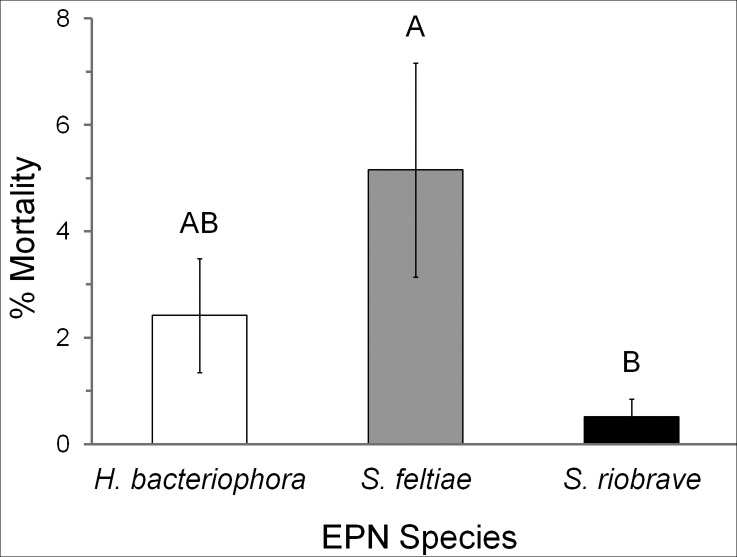
Mortality of wheat stem sawfly (Cephus cinctus) from field wheat stubble treated with three species of EPNs (Heterorhabditis bacteriophora, Steinernema feltiae, and Steinernema riobrave).Percent mortalities were pooled across EPN species and bars represent average percent mortality (mean ± SEM) for each species (N = 18). Different letters indicate significant differences in percent mortality (Tukey’s HSD, α = 0.05).